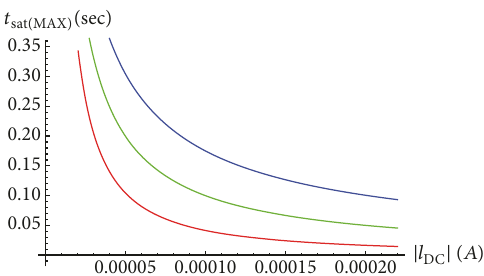
Figure 6: 𝑀(𝑡) of the boundary effect free fractional order memris- tor under the sinusoidal input with 𝐼 𝑚 = 110 𝜇 A and 𝛼 = 1.25 .